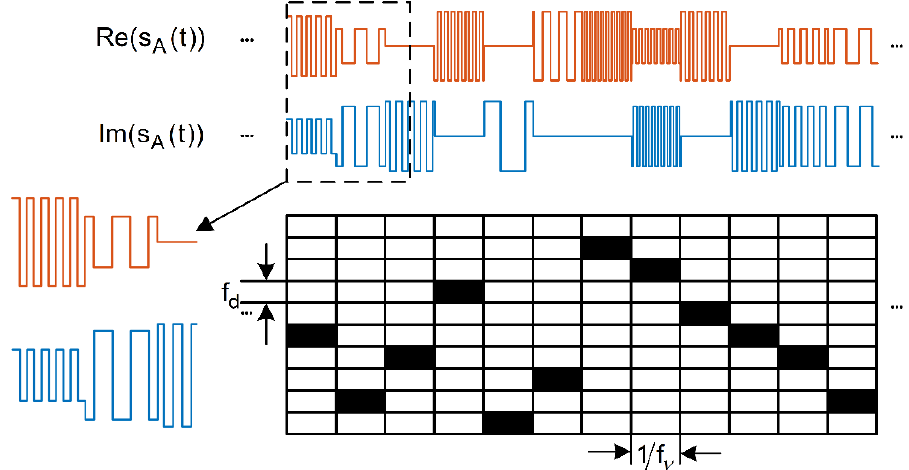
Figure 1. Waveforms of the real part and the imaginary part for the example signal.